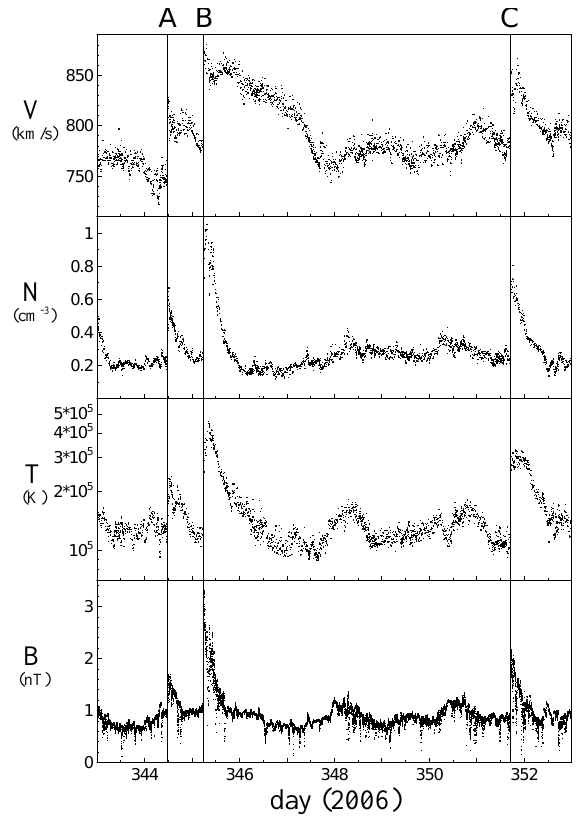
Fig. 5. From top to bottom: solar wind velocity V , proton number density N , proton temperature T , and magnetic field magnitude B for the events A, B, and C shown in Fig. 4. The time resolution is 4 or 8min for plasma data, depending on the spacecraft mode of operation, and 1min for magnetic